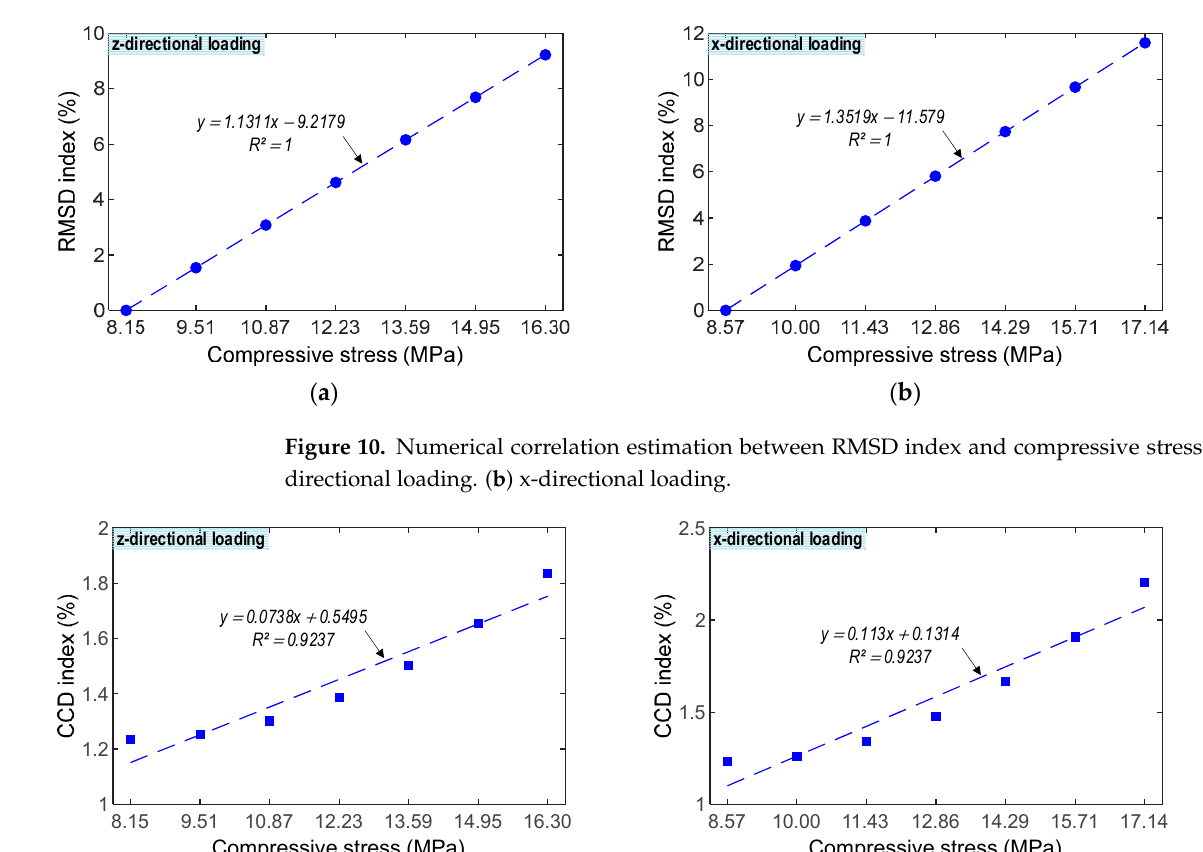
Figure 12. Fabrication of CSA prototype (dimension in mm). ( a ) PZT interface. ( b ) Bottom cover. ( c ) Top cover. ( d ) CSA. As shown in Figure 13, the impedance responses corresponding to the fabrication steps were experimentally measured for two CSA samples (CSA 1 and CSA 2). The im- pedance responses were examined for two stages: (1) a PZT interface (see Figure 12a) and (2) a complete CSA (see Figure 12d). At the stage of the PZT interface, only one impedance peak was measured in the frequency range of 10–40 kHz (151 points). Both PZT interfaces 1 and 2 had a peak impedance at 19.6 kHz. At the stage of the CSA, two impedance peaks were measured in the frequency of 10–40 kHz (151 points). CSA 1 had two impedance peaks at 22.4 kHz and 31.6 kHz, shifting from the peak impedance from the PZT interface 1. CSA 2 had two impedance peaks at 22.2 kHz and 31.4 kHz, shifting from the peak im- pedance from the PZT interface 2.